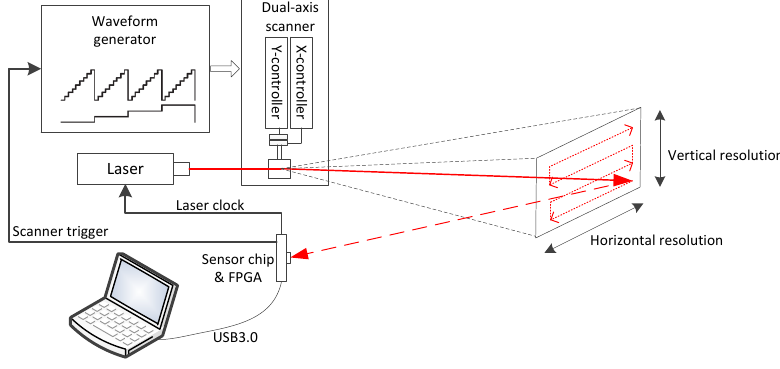
Figure 18. Block diagram of the LiDAR system.